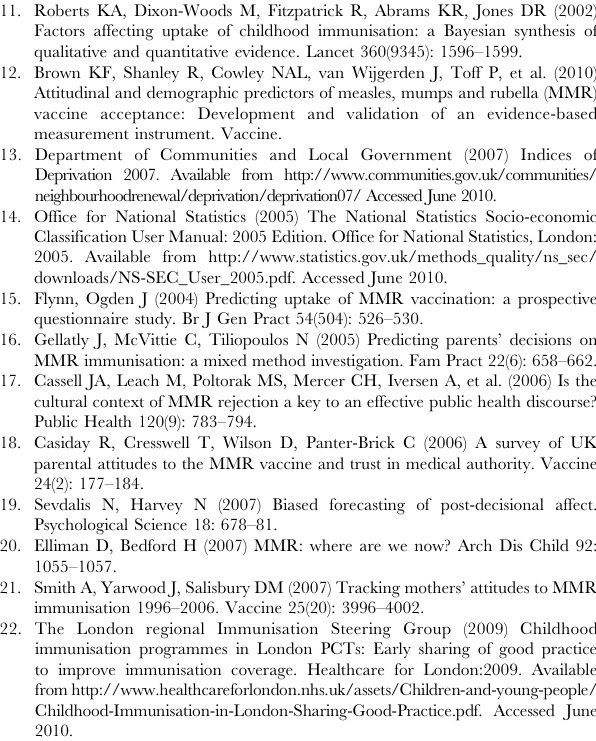
Table S1 Individual attitudes items by catch-up MMR